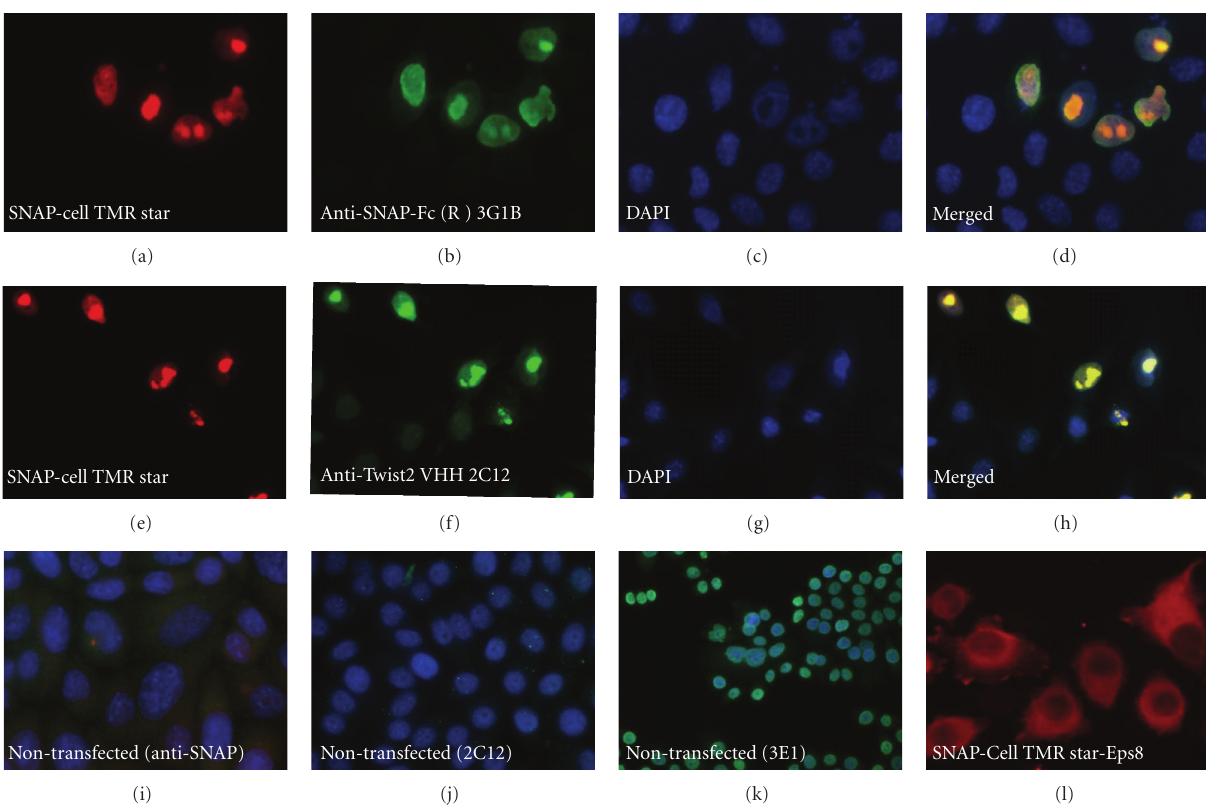
Figure 4: Double staining of SNAP-tagged Twist2 obtained by coupling specific antibodies and benzylguanine-fluorochromes. HeLa cells were transiently transfected using 20 μ g/plate of plasmid for the expression of the SNAP-Twist2 protein. Its subcellular localization was identified: (a) and (e) by the in vivo addition of the permeable SNAP-Cell TMR Star fluorochrome (dilution 1 :200); (b) by means of the purified recombinant anti-SNAP antibody 3G1B fused to the rabbit Fc (5 μ g/mL); (f) by means of the cell culture supernatant containing the recombinant anti-Twist2 VHH antibody 2C12 (dilution 1 :2); (d) and (h) are the merged images of (a)+(b) and (e)+(f), respectively; (c) and (g) correspond to the nuclear DAPI staining; (i), (j), and (k) are nontransfected cells (controls) treated with the indicated antibodies. HeLa cells transfected with SNAP-Epsin8 were stained with SNAP-Cell TMR Star fluorochrome (dilution 1: 200) to rule out a SNAP-dependent nuclear staining